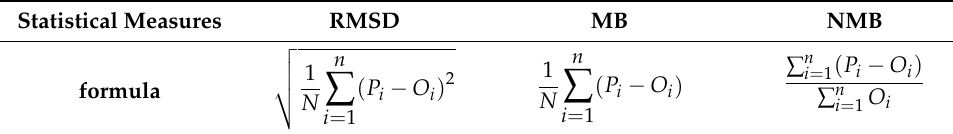
Table 1. Statistical formulae of RMSD, MBE, and